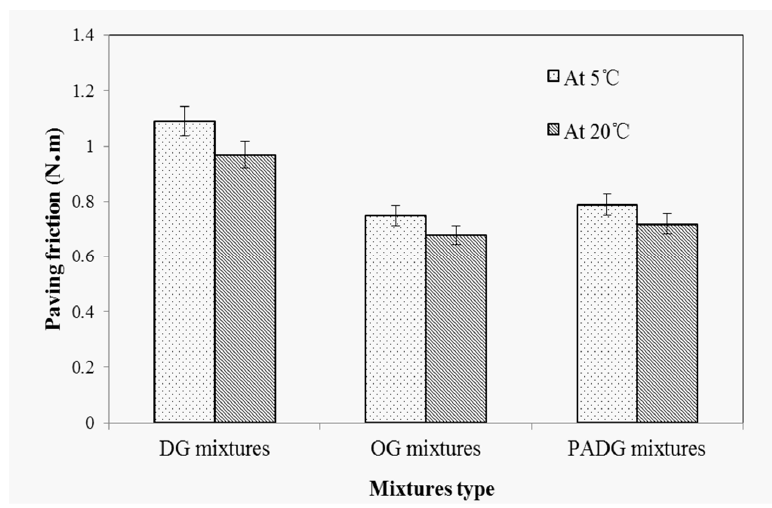
Figure 8. Paving friction of cold mixtures at different temperatures (at 5 °C and 20 °C).